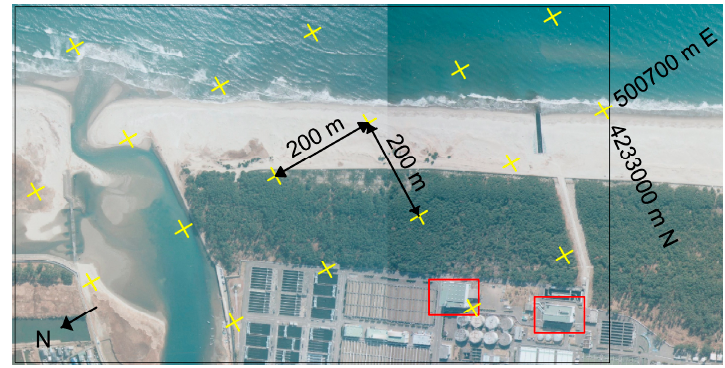
Figure 3. Rectified aerial photograph of the study area (taken on 6 March 2011).